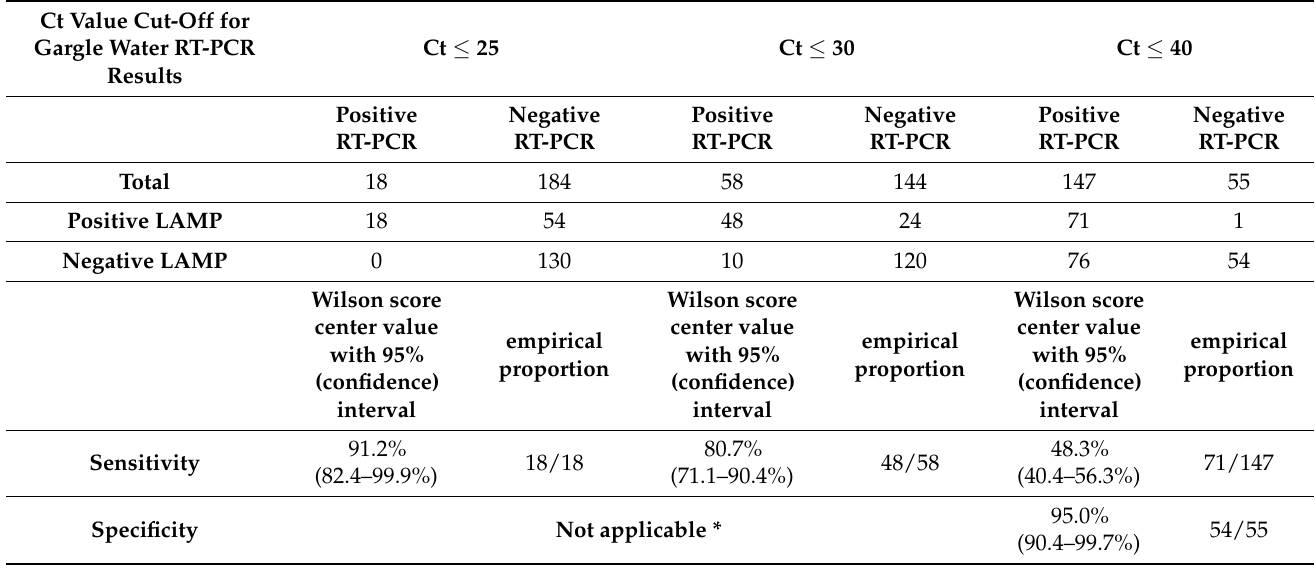
Table 2. The results of gargle water LAMP with respect to Ct value cut-offs for gargle water RT- PCR results.